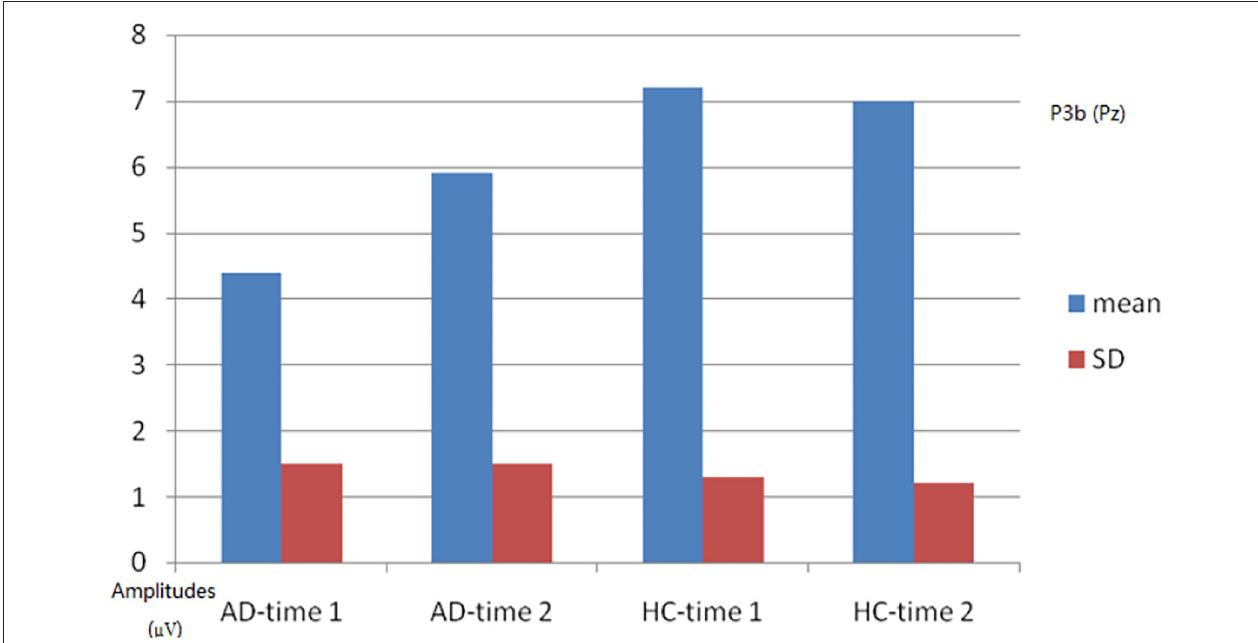
FIGURE 5 | Plot of P3b amplitude analysis. The interaction effect for group × time point was significant; the simple effect for group at time 1 level and time 2 level was significant; the simple effect for time point at the alcohol dependence (AD) group level was significant; the simple effect for time point at the healthy control (HC) group level was not